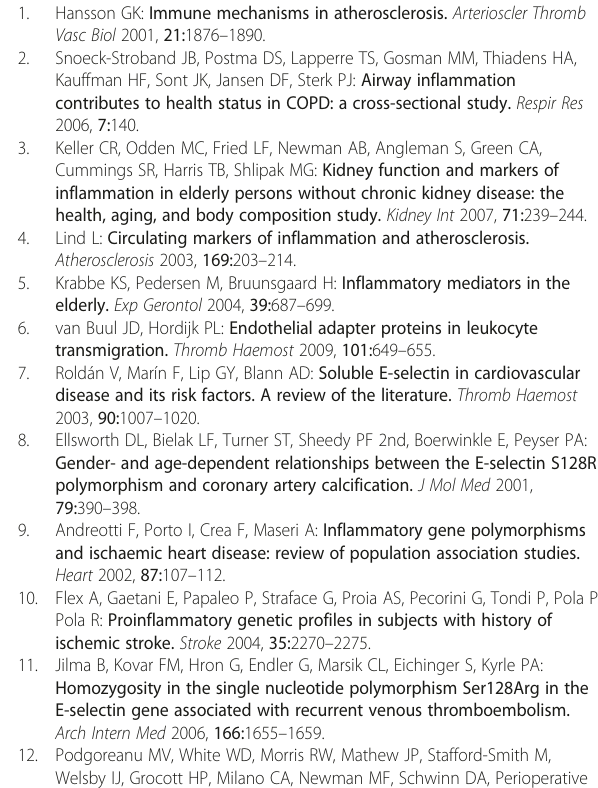
Additional file 1: Table S1. Primer sequences and restriction enzyme (RE) used in SELE gene polymorphisms. S2 . Linkage disequilibrium between SELE genetic